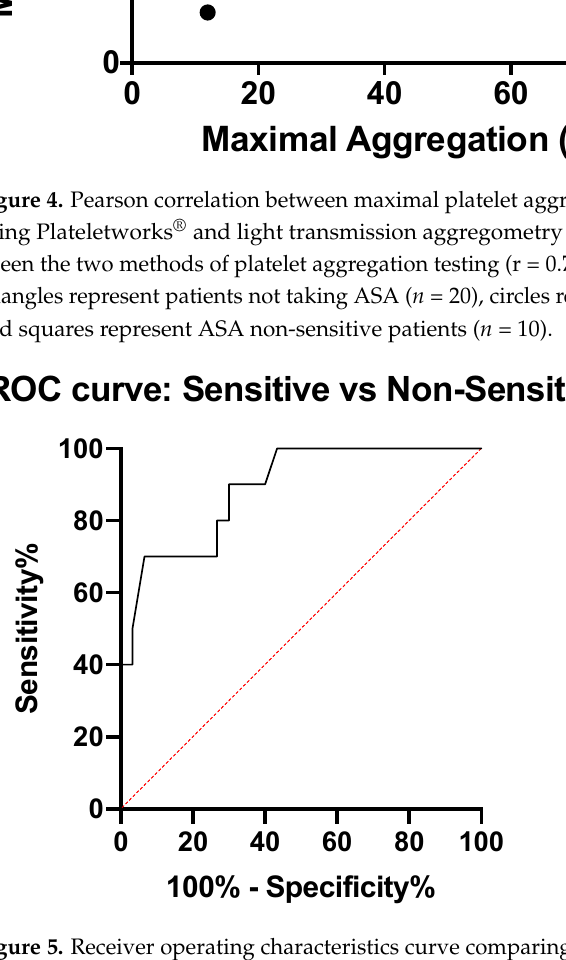
Figure 4. Pearson correlation between maximal platelet aggregation in response to Arachidonic acid using Plateletworks ® and light transmission aggregometry ( n = 60). There is a good correlation be- tween the two methods of platelet aggregation testing (r = 0.749, 95% CI: 0.6096 to 0.8432, p < 0.0001). Triangles represent patients not taking ASA ( n = 20), circles represent ASA-sensitive patients ( n = 30), and squares represent ASA non-sensitive patients ( n = 10).